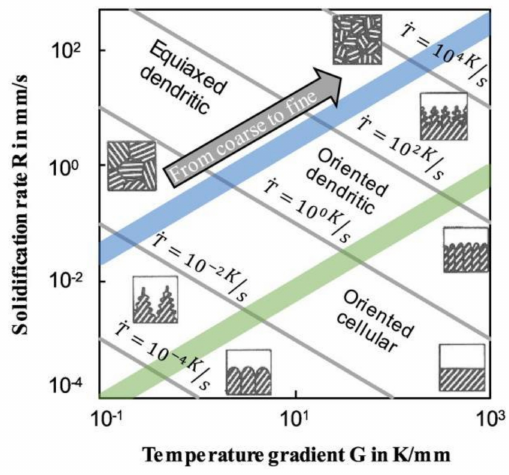
Figure 9. Solidification grain microstructure map